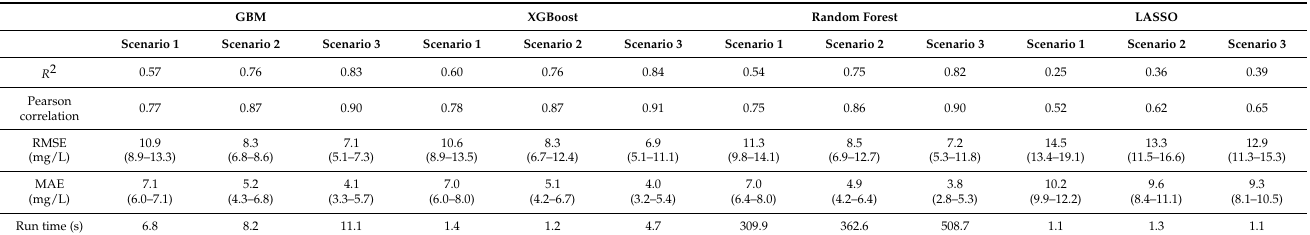
Table 3. Model performance for prediction of plasma concentration over time using varying amounts of information as